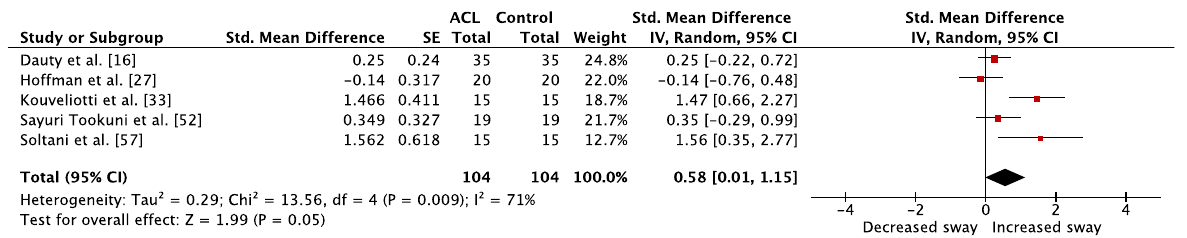
Fig. 8 Forest plot comparison of sway magnitude between the ACL-injured leg and ACL-non-injured leg. Std . standardized, SE standard error, IV inverse variance, CI confidence interval, df degrees of freedom, ACL anterior cruciate ligament